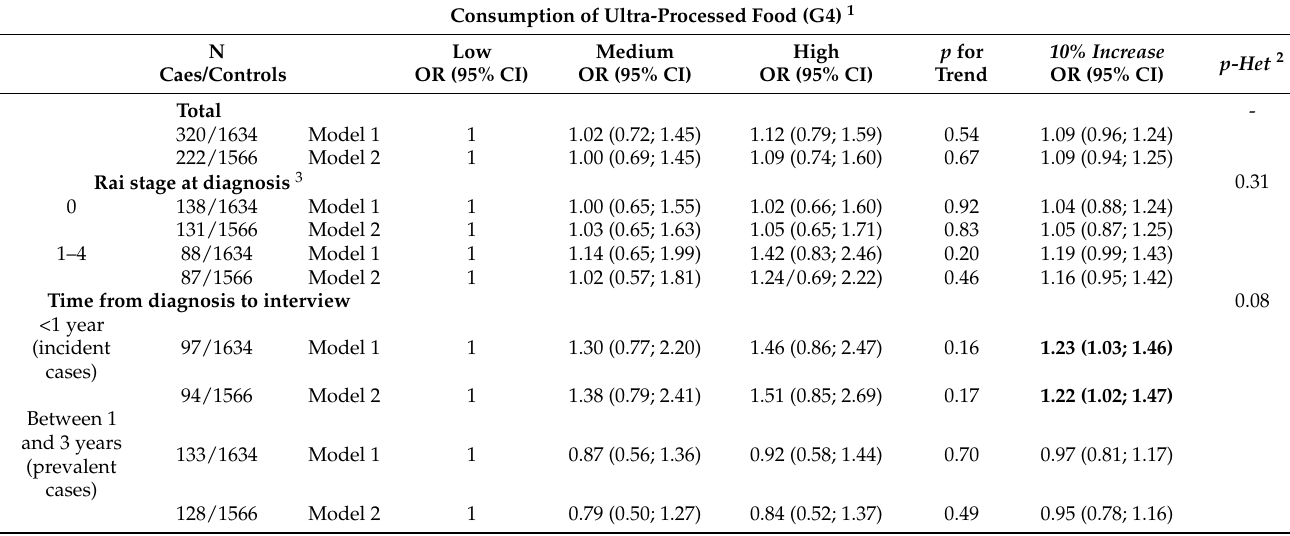
Table 3. Association between the consumption of ultra-processed food (NOVA classification, group 4) and chronic lymphocytic leukemia overall by Rai stage and the time from diagnosis to interview in the MCC-Spain